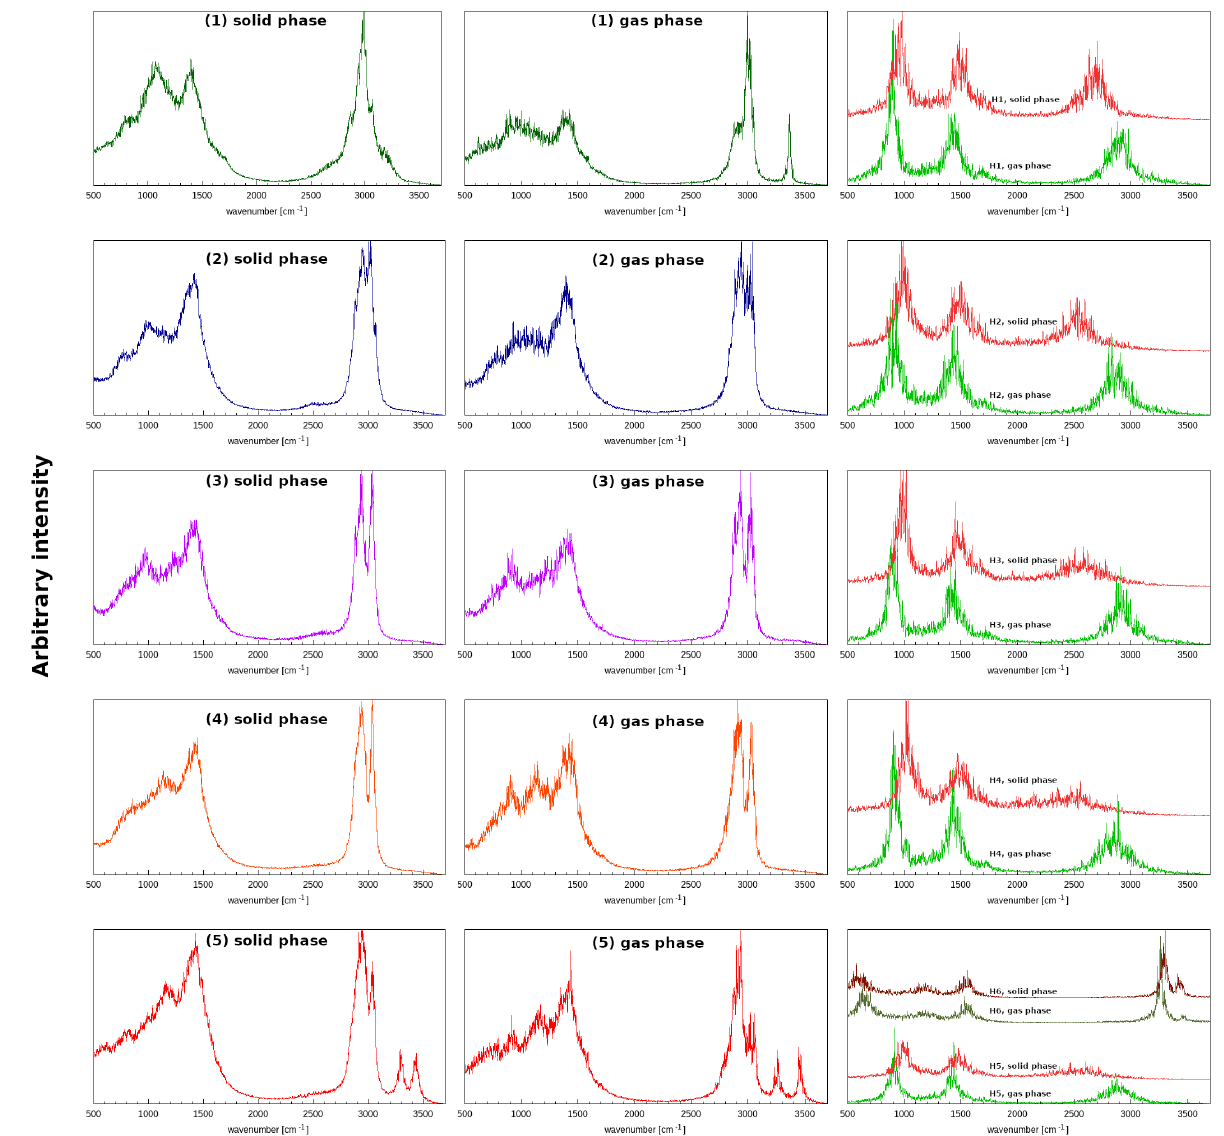
Figure 5. Atomic velocity power spectra of the studied quinolone carboxylic acid derivatives as results of the CPMD simulations. Left panel : the whole atom spectra in the solid state. Middle panel : the whole atom spectra in the gas phase. Right panel : the contribution of the bridged proton in the gas and solid